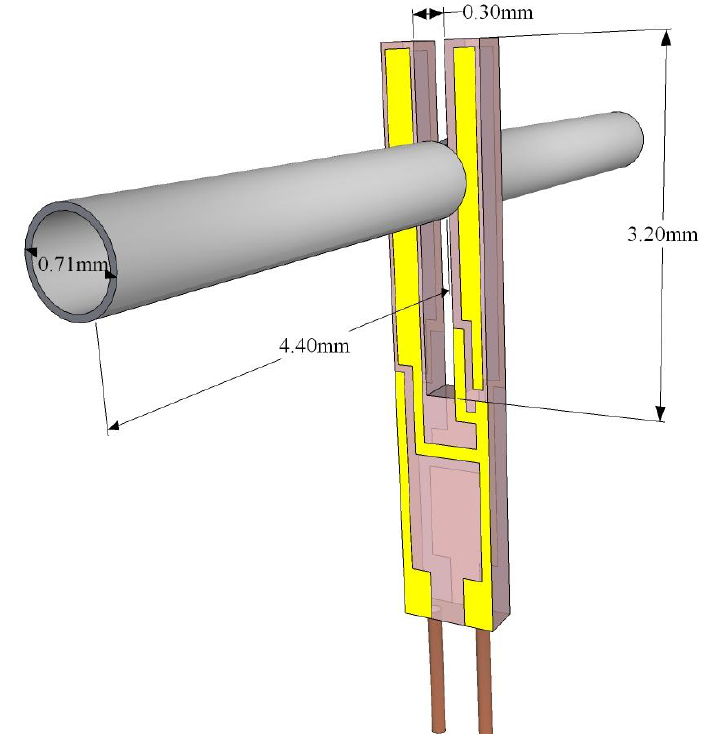
Figure 6. Schematic of an on-beam QEPAS configuration. Two micro-resonator tubes are aligned perpendicular to the QTF plane to probe the acoustic vibration excited in the gas contained inside the